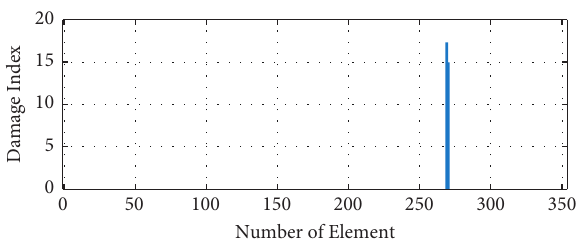
Figure 25: Results of single damage case D1 using MCA-DI (setback